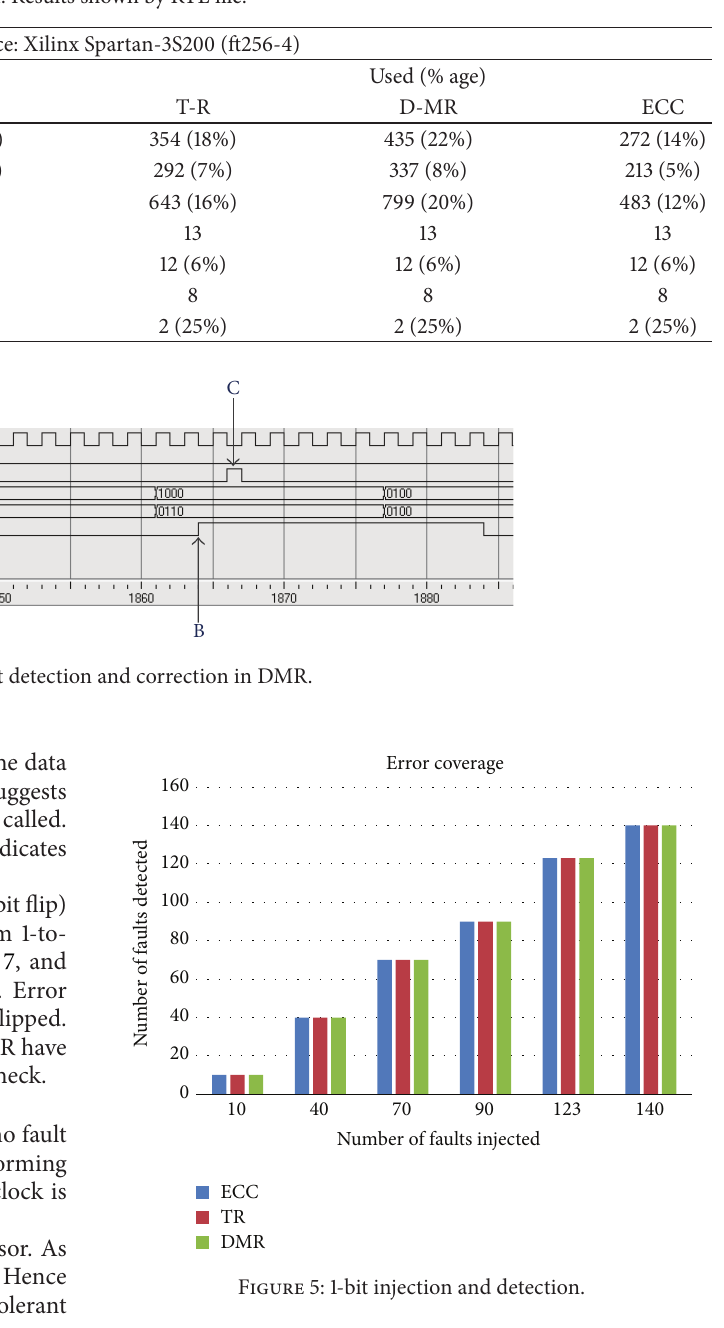
Table 1: Results shown by RTL file.